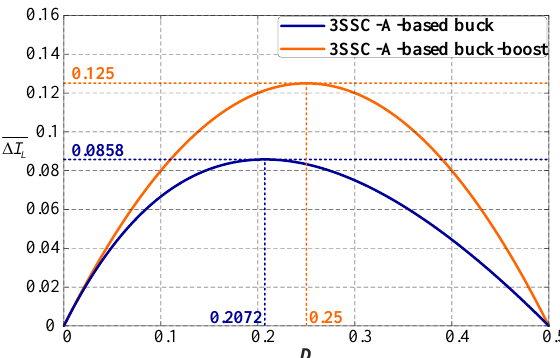
Figure 5. Ripple current through the inductor.